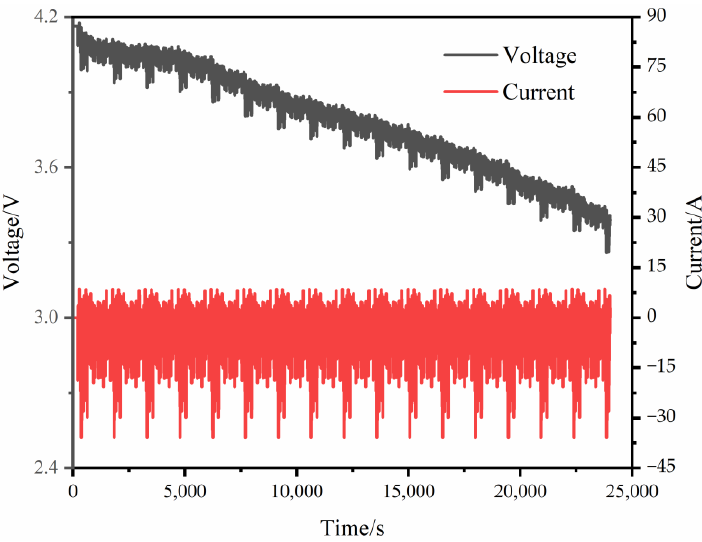
Figure 5. UDDS working voltage and current diagram.